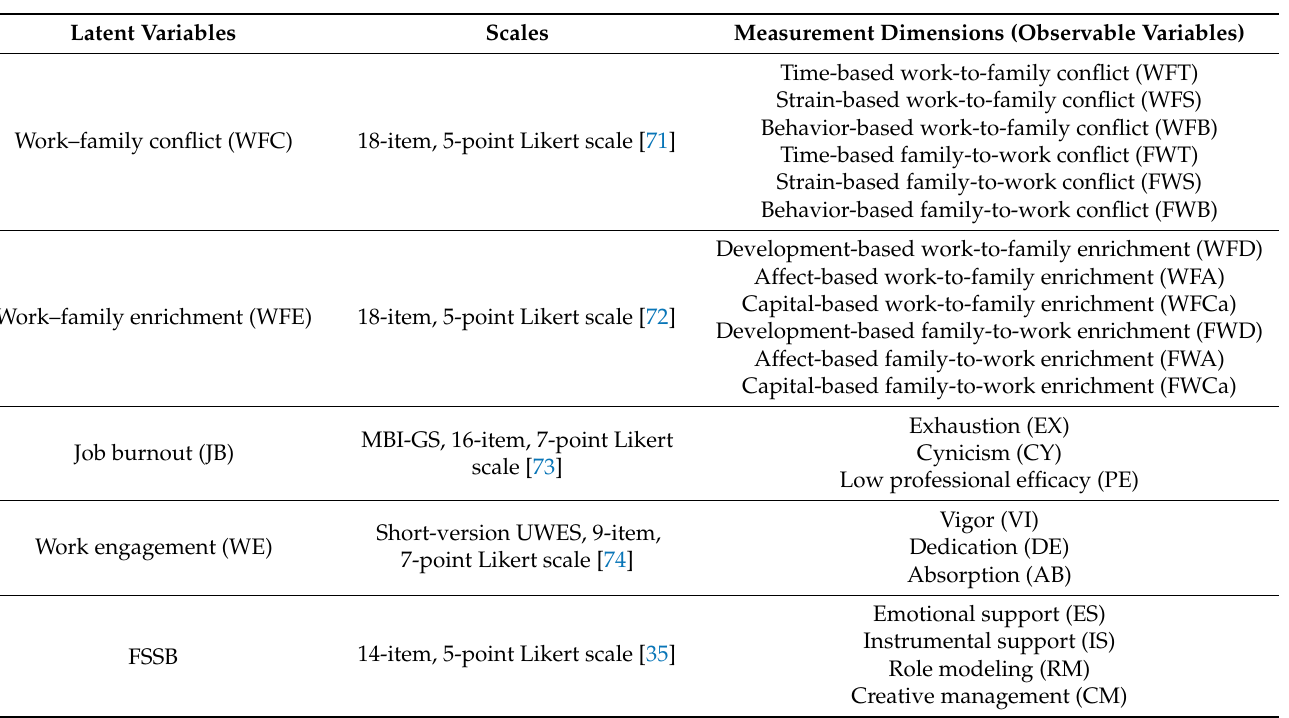
Table 1. Scales for